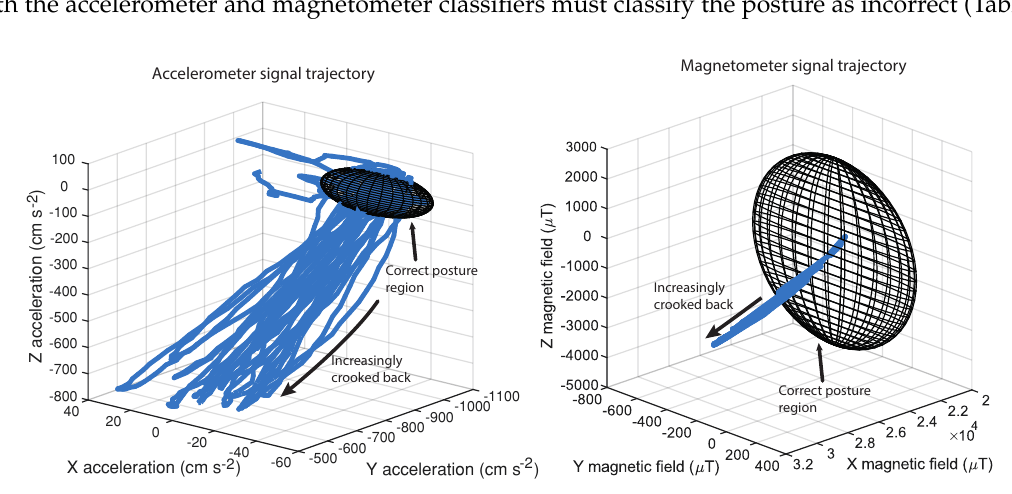
Figure 4. Regions of confidence for a correct posture while standing with arms down (meshed ellipsoid) and trajectory of sensor data during a test (blue line). The plot on the left is related to accelerometer data, while the plot on the right is related to magnetometer